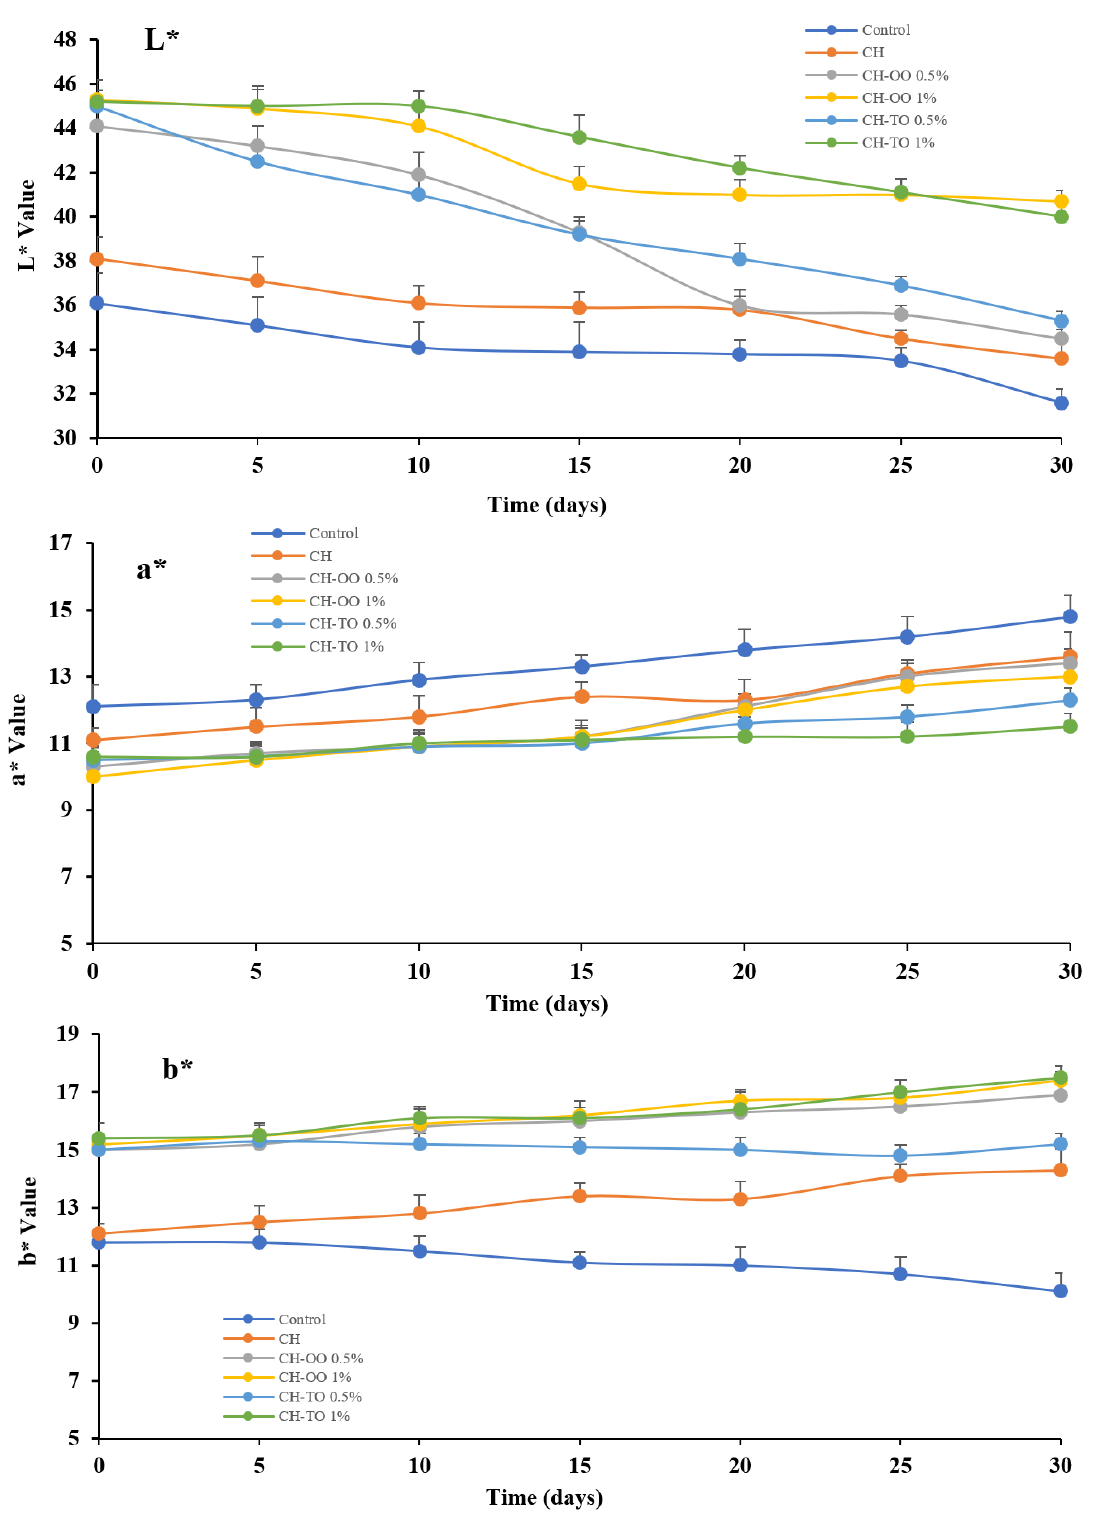
Figure 5. Impact of chitosan (CH) film incorporated oregano (OO) and thyme (TO) essential oils on beef color parameters i.e., L* value, a* value, and b* value during storage time. Error bars indicate standard deviation, (n = 3). Control: without film and oil; CH: chitosan; CH − OO 0.5%: chitosan+ oregano oil 0.5%; CH − OO 1%: chitosan+ oregano oil 1%; CH − TO 0.5%: chitosan+ thyme oil 0.5%; CH − TO 1%: chitosan+ thyme oil 1%.